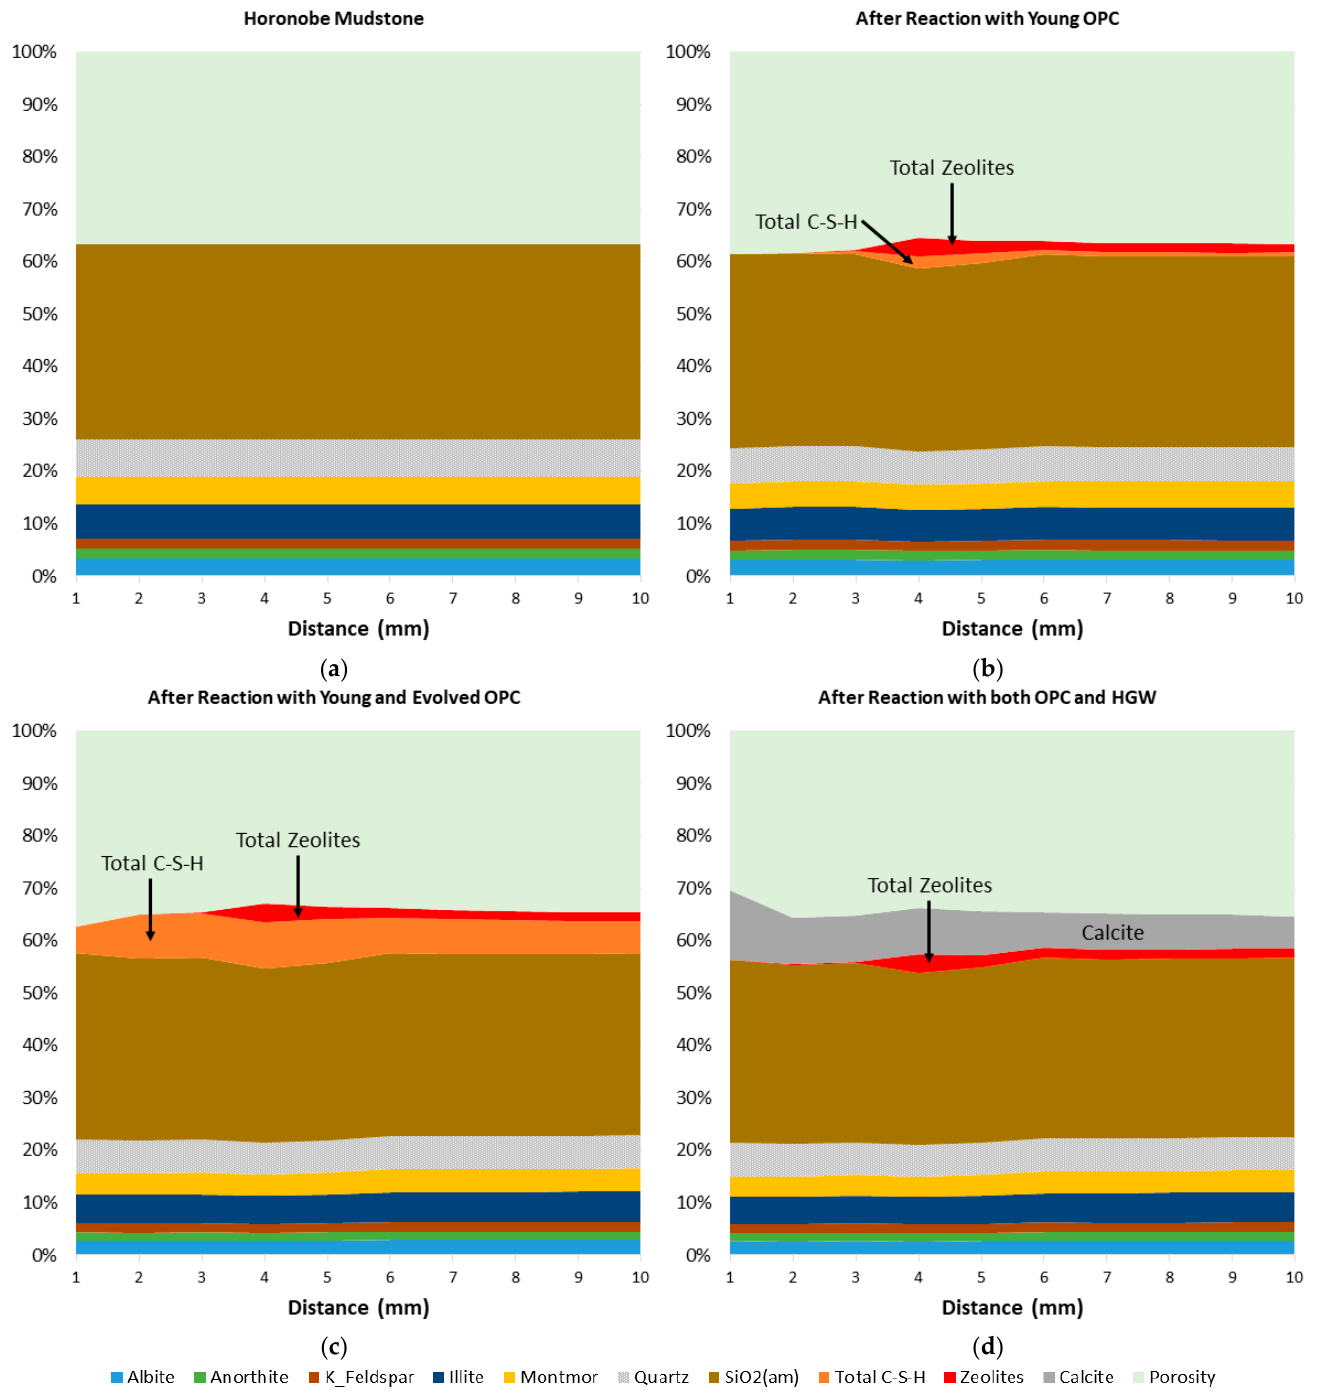
Figure 11. Legend for all plots. Summary of the composition of modelled mineral assemblage: ( a ) Horonobe mudstone before reaction; ( b ) after reaction with young for 40 d; ( c ) after successive reaction with both OPC leachates; and ( d ) after successive reaction with both OPC leachates and Horonobe groundwater.